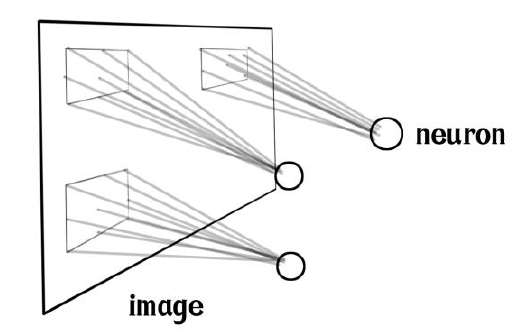
Figure 1. Local Perception of CNN